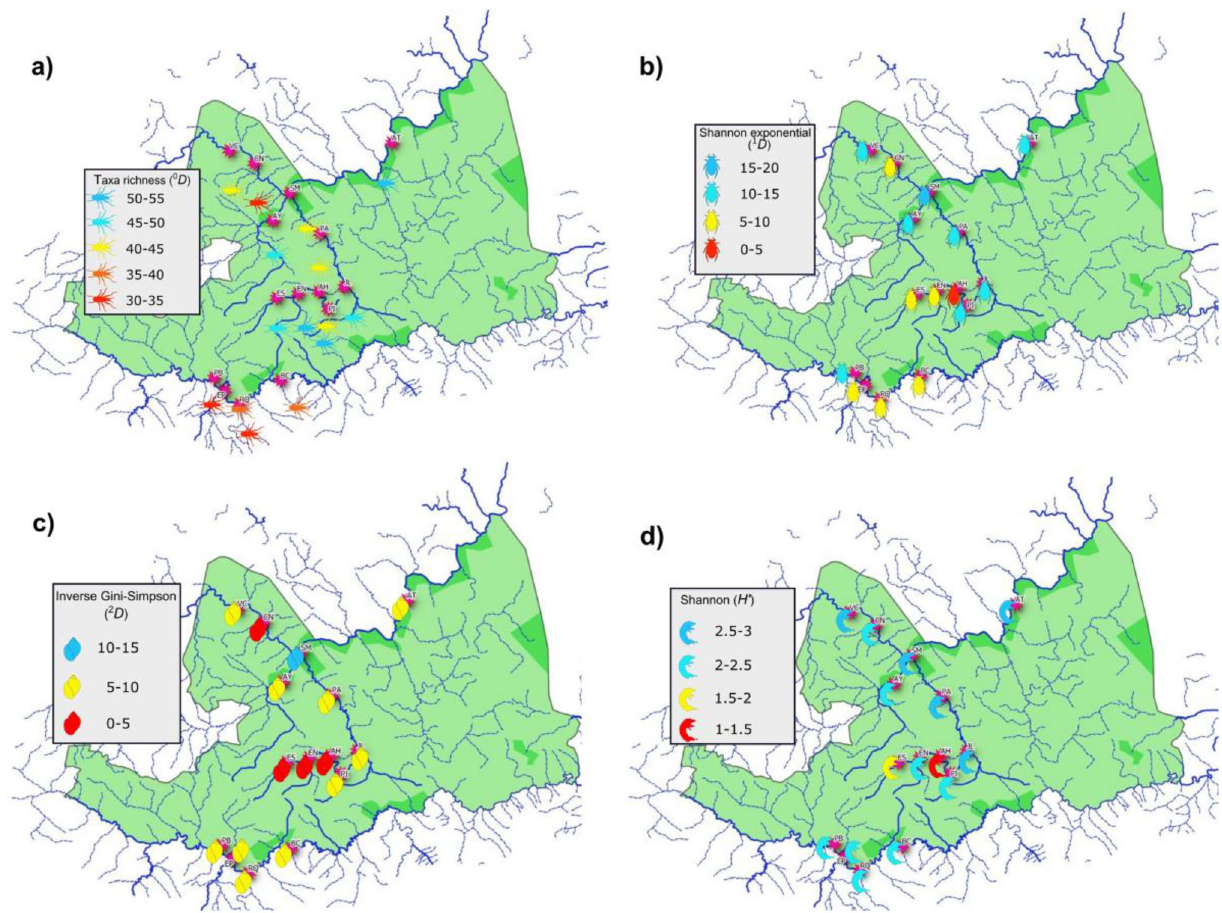
Figure 1. Heatmap of diversity indices for the study sites in the SGBR: (a) taxa richness, (b) Shannon exponential index, (c) Inverse Gini-Simpson index, (d) Shannon index. The regional map was generated using the vectorial layers freely available from National Institute of Statistics, Geography and Informatics (https:// www. inegi. org. mx/ temas/ mapad igital) and National Commission of Protected Natural Areas (http:// sig. conanp. gob. mx/ websi te/ pagsig/ info_ shape. htm. All layers were processed with the open source software geographic information system QGIS 3.18 (QGIS is open source software available under the terms of the General Public License (GNU) meaning that source codes can be downloaded through tarballs or the git repository). Study site points were downloaded from a hand-held GPS (Monterra ® |Garmin) before being digitized and uploaded